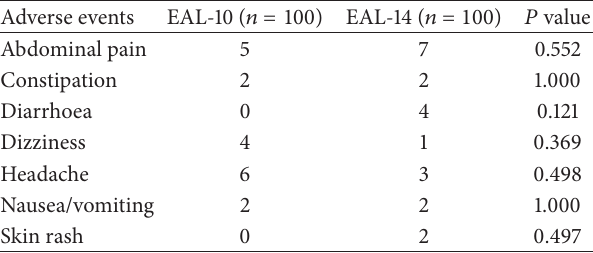
Table 3: Adverse events during EAL-10 and EAL-14 therapies. Adverse events